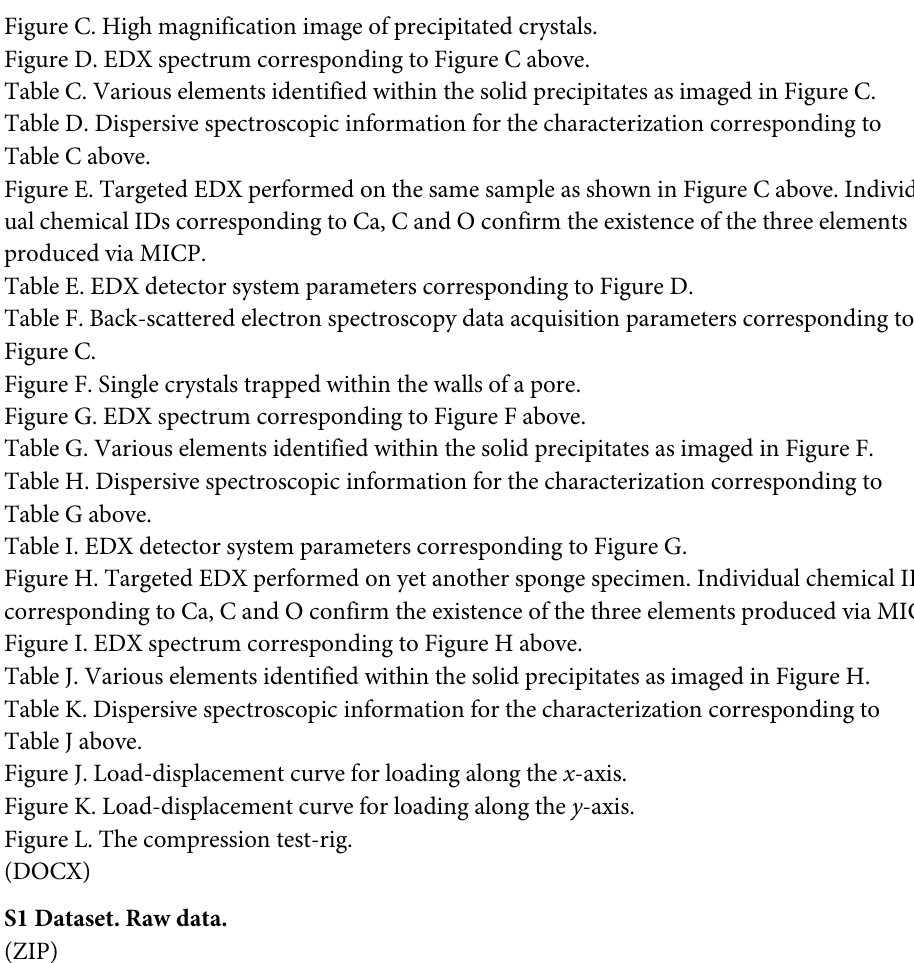
Figure C. High magnification image of precipitated crystals. Figure D. EDX spectrum corresponding to Figure C above. Table C. Various elements identified within the solid precipitates as imaged in Figure C. Table D. Dispersive spectroscopic information for the characterization corresponding to Table C above. Figure E. Targeted EDX performed on the same sample as shown in Figure C above. Individ- ual chemical IDs corresponding to Ca, C and O confirm the existence of the three elements produced via MICP. Table E. EDX detector system parameters corresponding to Figure D. Table F. Back-scattered electron spectroscopy data acquisition parameters corresponding to Figure C. Figure F. Single crystals trapped within the walls of a pore. Figure G. EDX spectrum corresponding to Figure F above. Table G. Various elements identified within the solid precipitates as imaged in Figure F. Table H. Dispersive spectroscopic information for the characterization corresponding to Table G above. Table I. EDX detector system parameters corresponding to Figure G. Figure H. Targeted EDX performed on yet another sponge specimen. Individual chemical IDs corresponding to Ca, C and O confirm the existence of the three elements produced via MICP. Figure I. EDX spectrum corresponding to Figure H above. Table J. Various elements identified within the solid precipitates as imaged in Figure H. Table K. Dispersive spectroscopic information for the characterization corresponding to Table J above. Figure J. Load-displacement curve for loading along the x -axis. Figure K. Load-displacement curve for loading along the y -axis. Figure L. The compression test-rig.